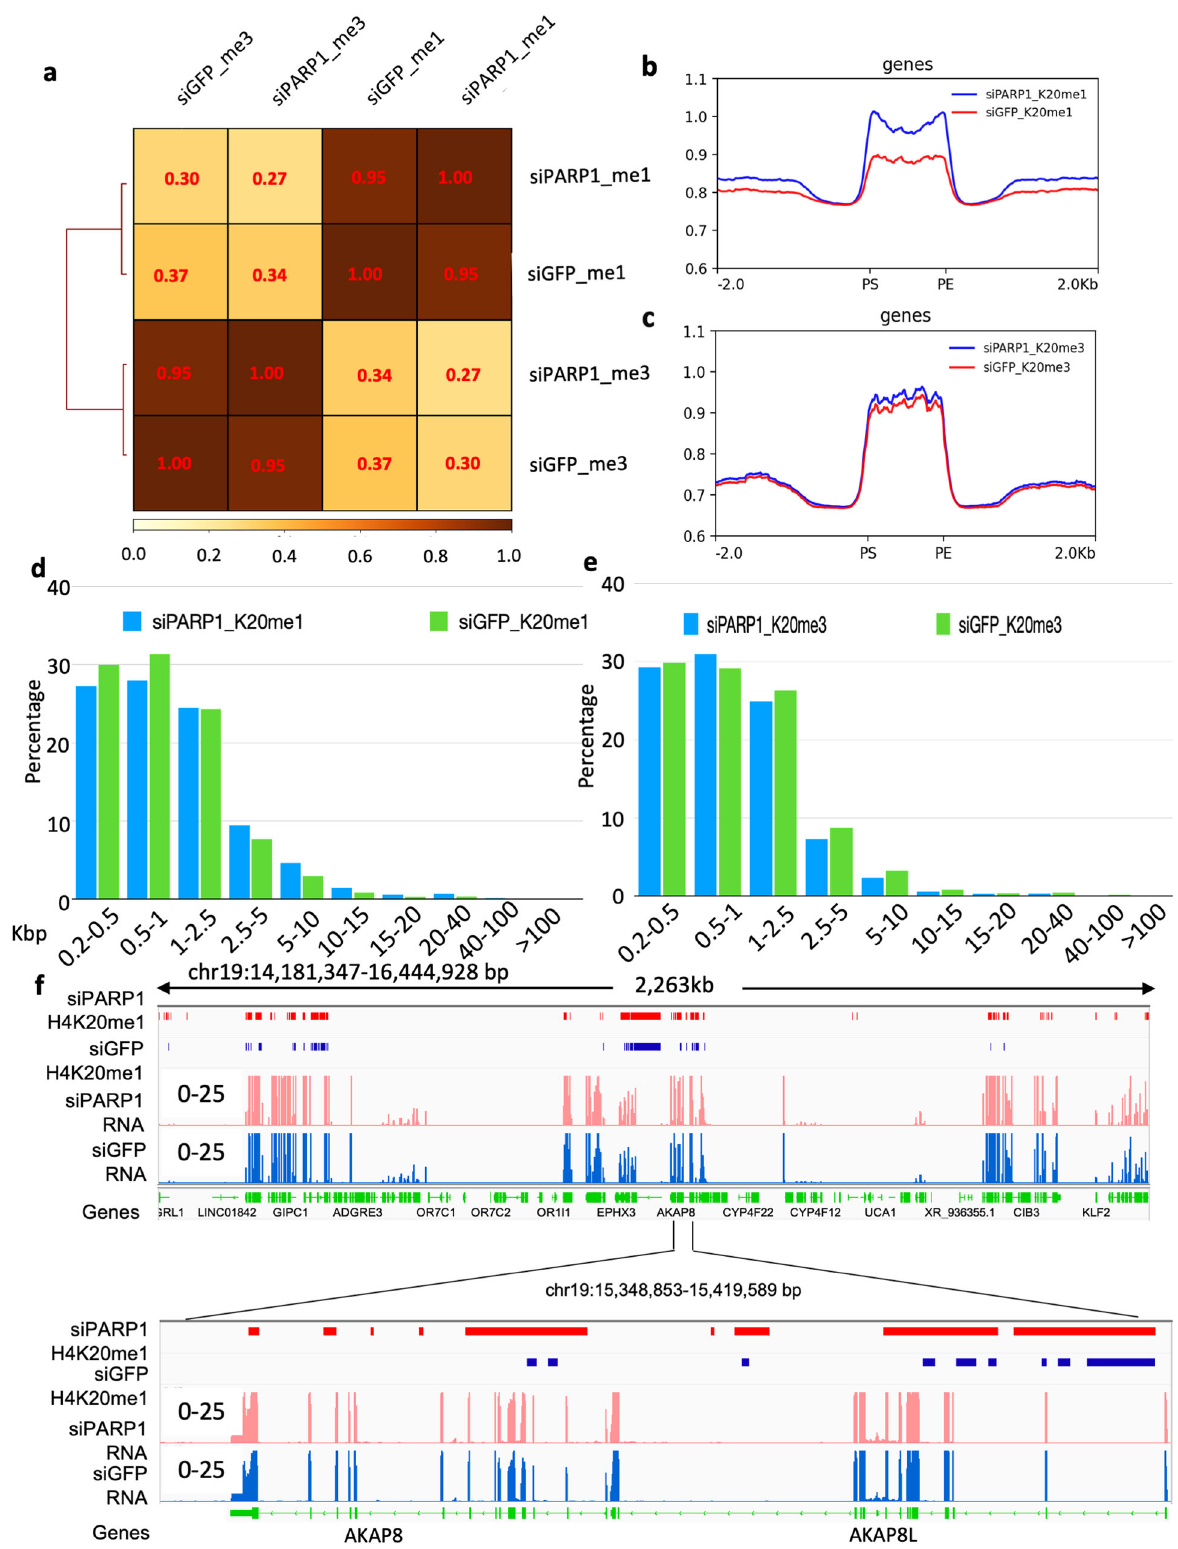
Fig. 6 PARP1 regulates H4K20me1 and H4K20me3 distribution in the genome. a Spearman correlation of H4K20me1 and H4K20me3 regions in PARP1 knockdown HeLa cells and its control. b Genome-wide metagene plot showing H4K20me1 pro fi le (ChIP-seq) in control and PARP1 knockdown HeLa cells. c Genome-wide metagene plot showing H4K20me3 pro fi le (ChIP-seq) in control and PARP1 knockdown HeLa cells. d Peak width pro fi le of H4K20me1 by binning the peaks into different lengths in PARP1 knockdown cells and its control. e Peak width pro fi le of H4K20me3 by binning the peaks into different lengths in PARP1 knockdown cells and its control. f Representative IGV genomic tracks showing H4K20me1 and RNAseq pro fi le in PARP1 knockdown cells and its